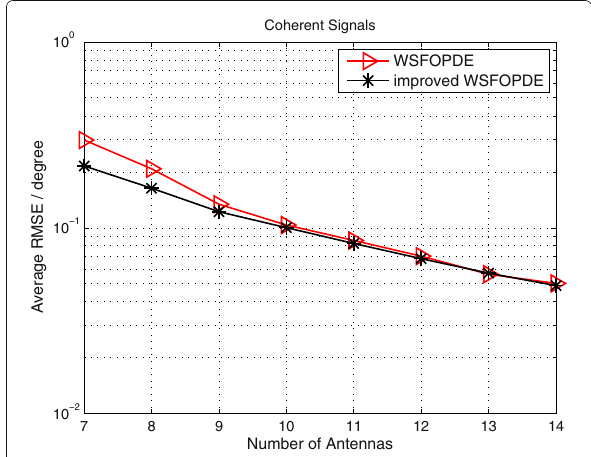
Fig. 10 The RMSE performance with different configuration of M